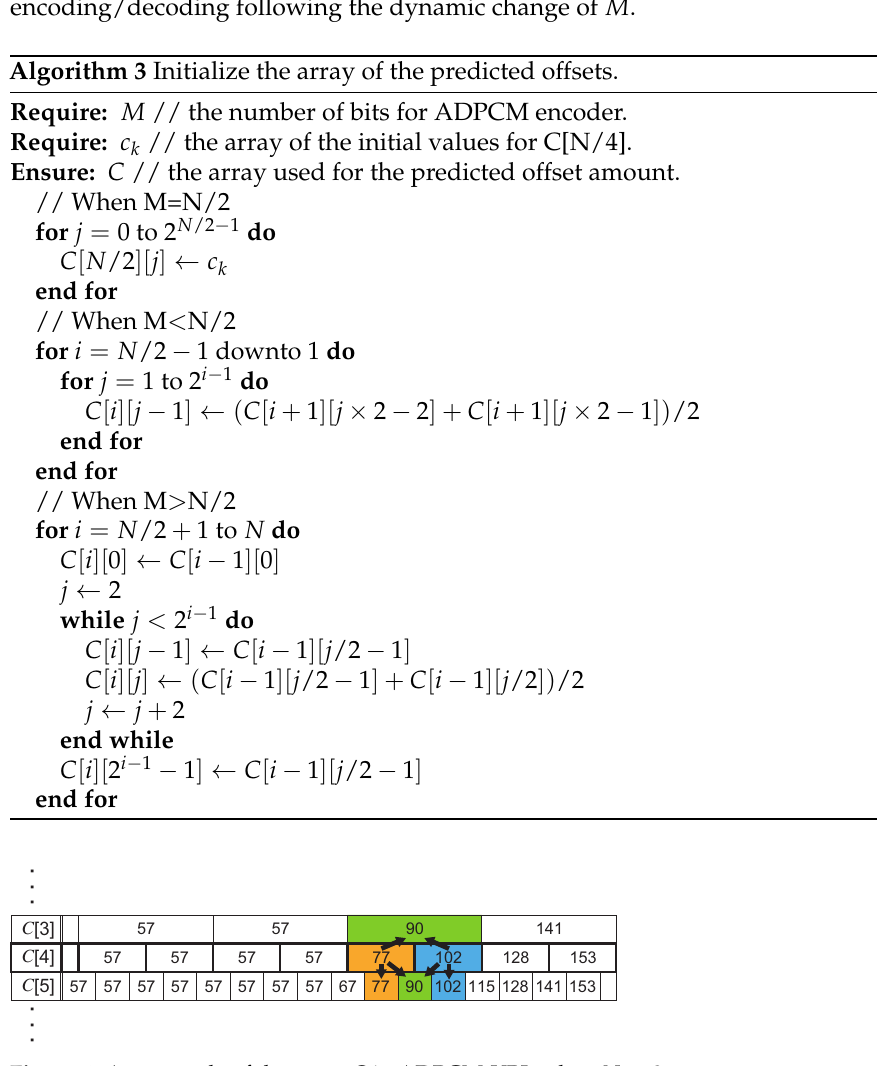
Figure 4. An example of the array C in ADPCM-VBL when N = 8. The algorithms of initialization and encoding/decoding for ADPCM-VBL that the modifi- cations above are applied are shown in Algorithms 4–6, respectively. Before encoding/decoding using those algorithms, the initialization is invoked when the video transfer system is